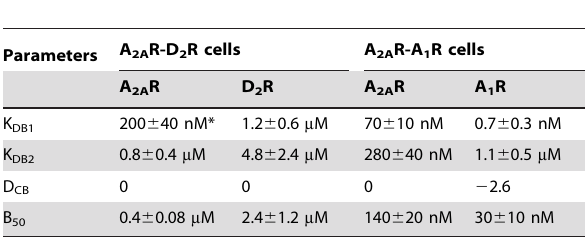
Table 2. Pharmacological parameters for agonist binding